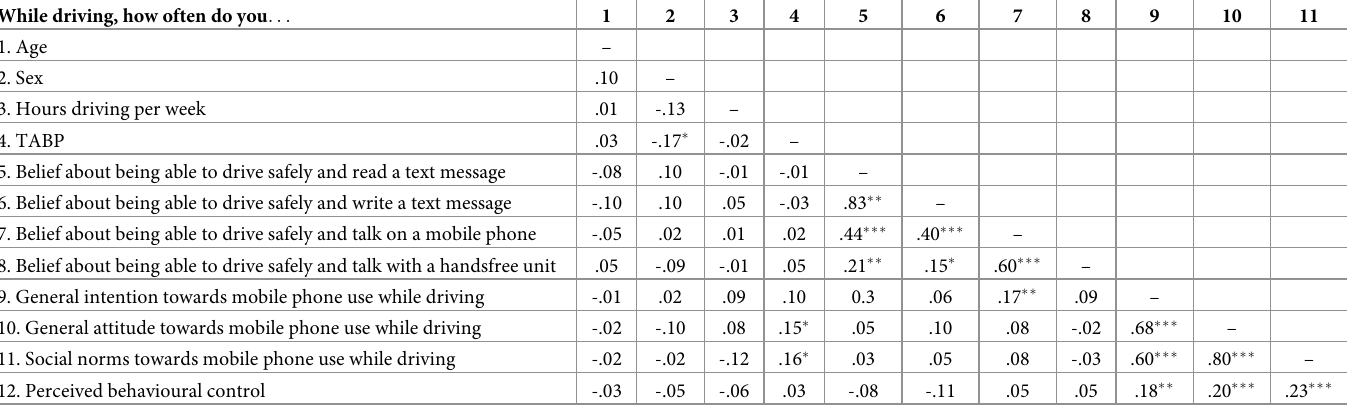
Table 3. Associations between age, sex, hours driven per week, TABP, specific beliefs about being able to engage in secondary tasks and drive safely, and TPB vari- ables (N = 220). While driving, how often do you